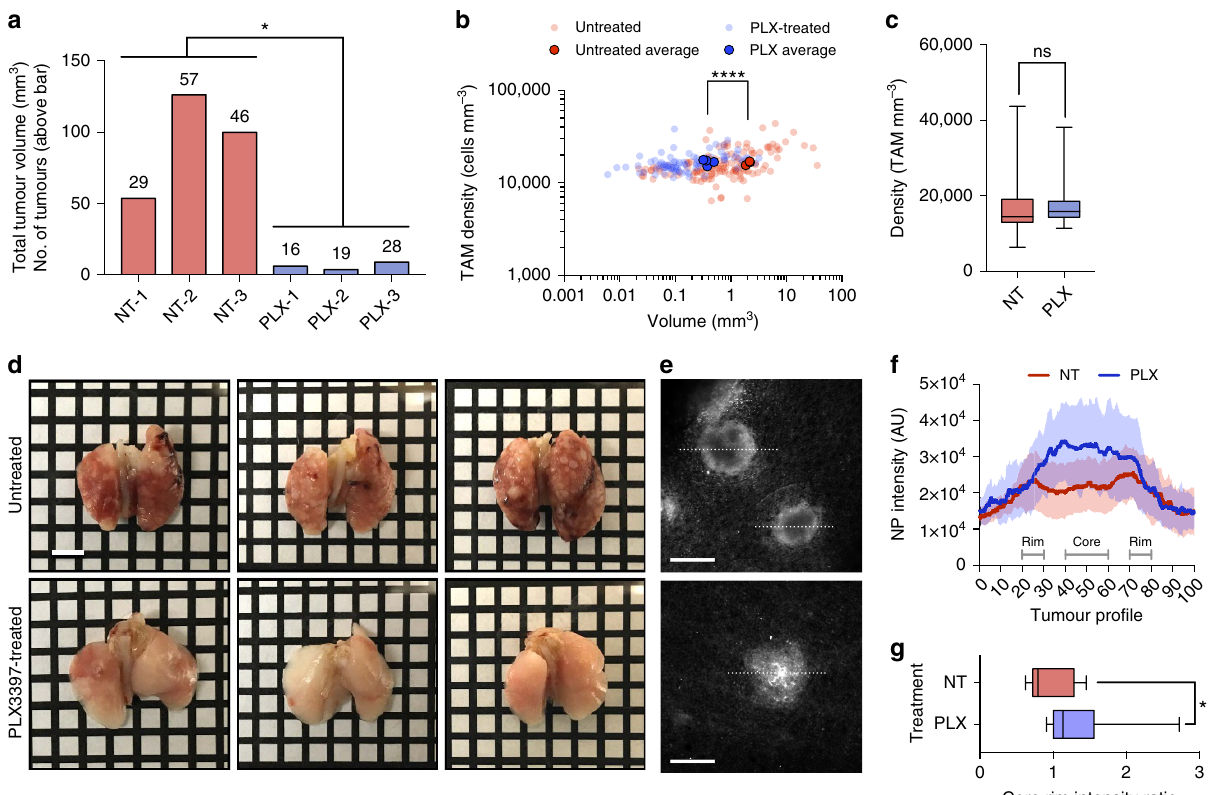
Figure 4 | PLX3397 monotherapy decreases tumour burden and alters TAM density and infiltration. ( a ) Reduced tumour burden in PLX3397 (PLX) treated mice relative to untreated (NT) ( n ¼ 6, P ¼ .015; unpaired t -test). Bars represent total tumour volume with number of identified tumours indicated above each bar. ( b ) Plot of TAM density against tumour volume, showing PLX3397-treatment resulted in significantly smaller tumour nodules ( n ¼ 423, P o .0001; unpaired t -test) ( c ) Data from b arranged to compare TAM densities in tumours from untreated and PLX3397-treated mice. ( d ) Representative images of lungs from untreated and PLX3397-treated lungs before tissue clearing (compare to a and b ). Scale bar, 5mm. ( e ) Representative images of treated and untreated tumours illustrate differences in TAM invasion. Scale bar, 1,000 m m. ( f ) NP fluorescence intensity corresponding to linear regions of interest placed across treated and untreated tumours, generating TAM intensity profiles. Tumours were normalized by size and plotted as a function of NP signal. ( g ) TAM localization was significantly altered within individual nodules. PLX3397-treated tumours have a greater ratio of NP signal in the tumour core relative to the rim ( n ¼ 14 for each group, P ¼ .025, 40–60% across tumour/0–10% þ 90–100%; unpaired t